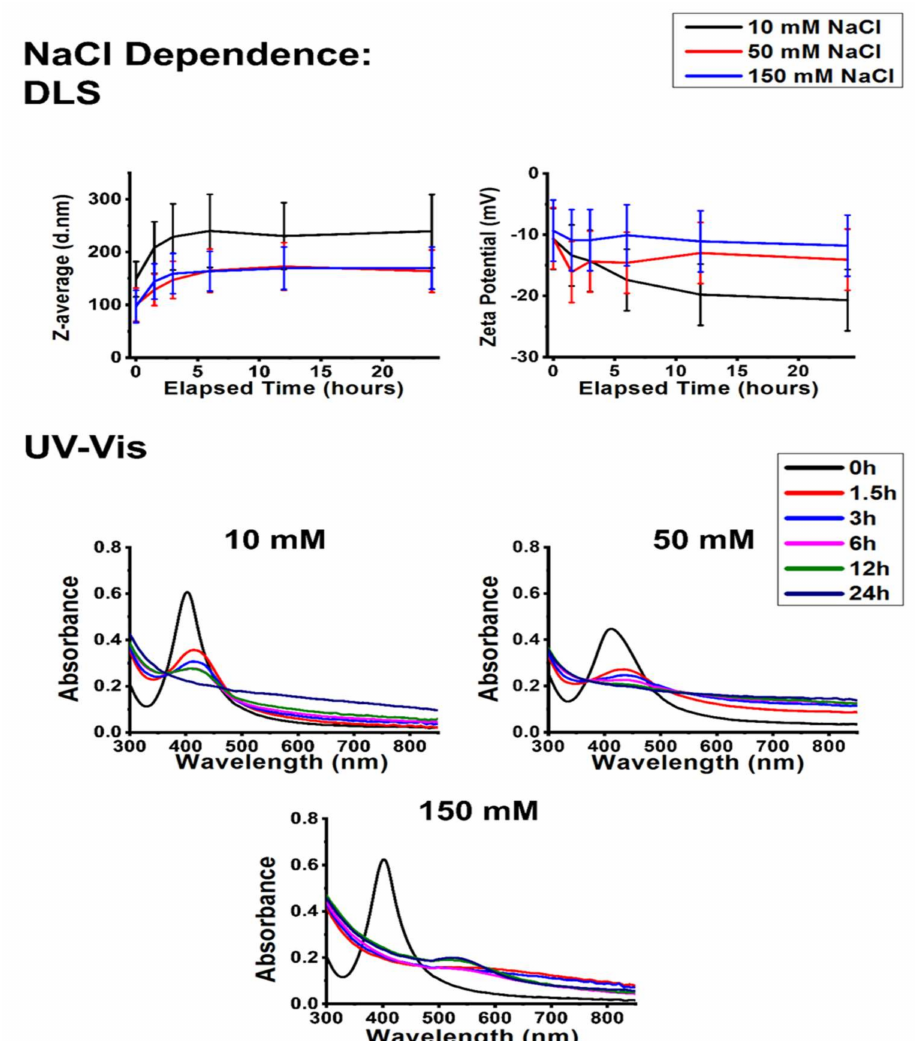
Figure 4. The effect of physiological NaCl concentrations on the stability of AgNP@PVP. Average hydrodynamic diameter (Z-average) and zeta potential changes (top panels) obtained by dynamic light scattering (DLS) and UV–Vis absorbance spectra (bottom panels) of polyvinyl-pyrrolidone- stabilized silver nanoparticles, recorded under various NaCl concentrations over a 24-h